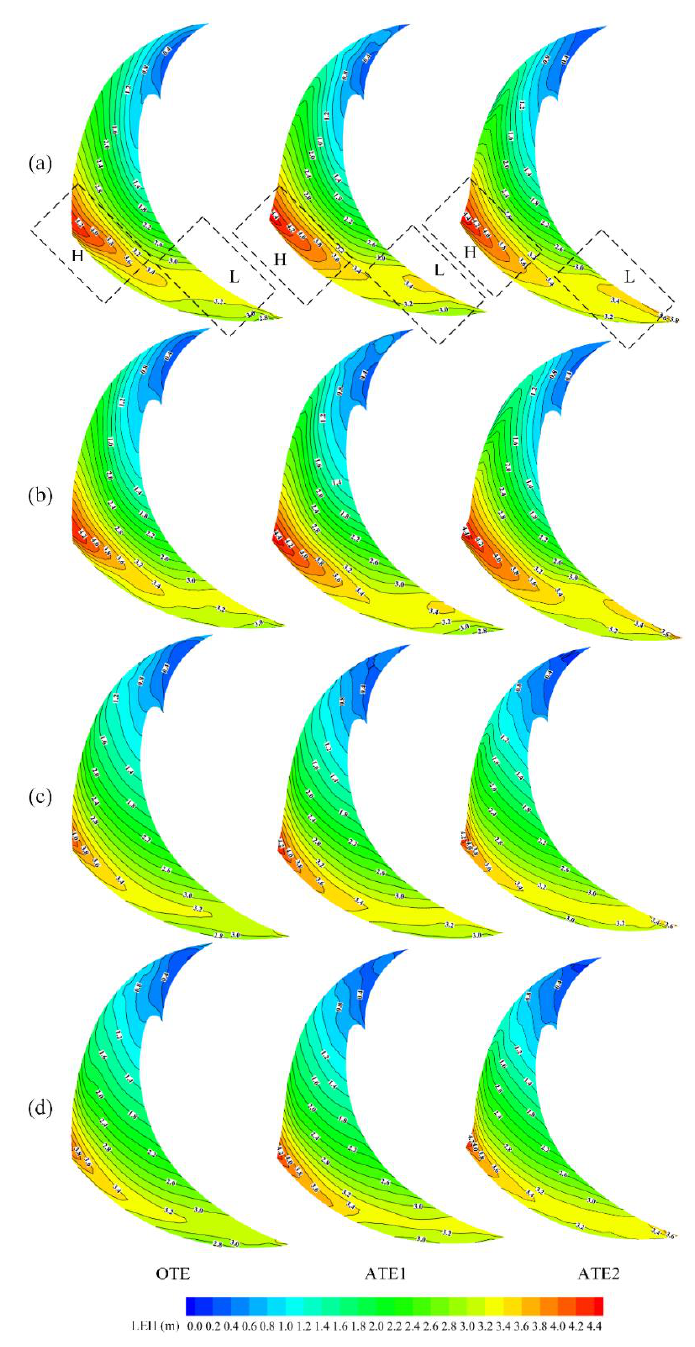
Figure 15. The contour of local Euler head at different flow rate conditions: ( a ) 0.2 Q BEP ; ( b ) 0.4 Q BEP ; ( c ) 1.0 Q BEP ; and ( d ) 1.2 Q BEP .